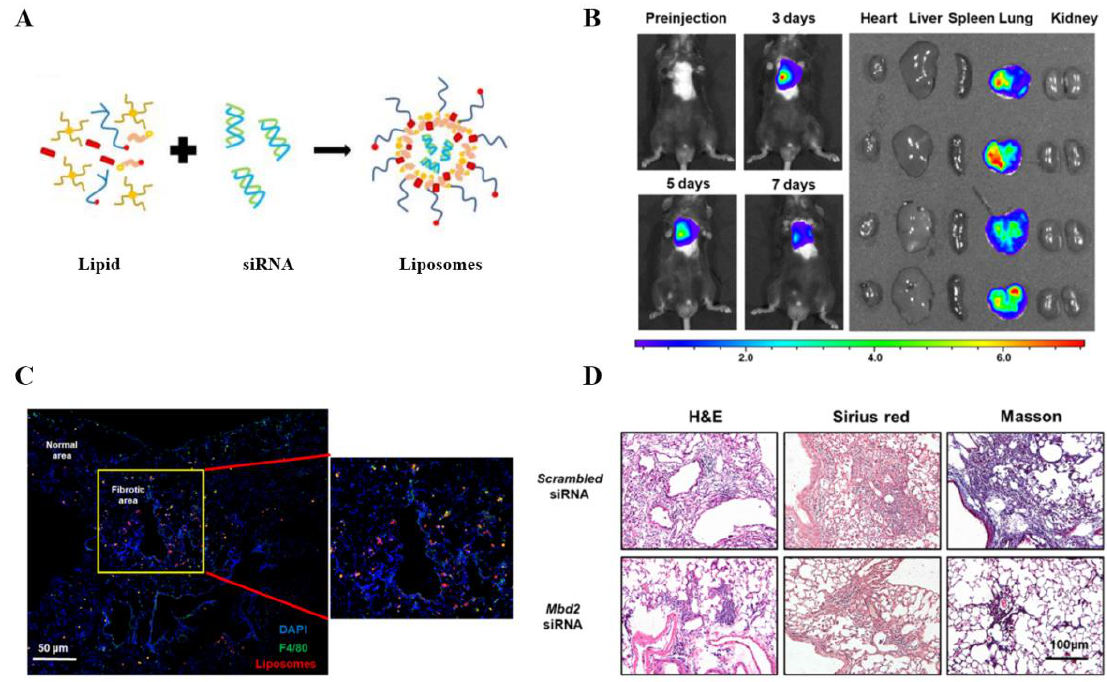
Figure 5. Mbd2 siRNA-loaded liposomes protected mice from BLM-induced pulmonary fibrosis [59]. ( A ) Schematic diagram of Mbd2 siRNA-loaded liposomes preparation. ( B ) Representative in vivo images of the mouseintratracheally administrated with DiR-labeled liposomes ( Left ) and ex vivo images of major organs from mice ( Right ). ( C ) Thebiodistribution of liposomes in lungs from BLM- induced mice. ( D ) Representative results for H&E, Sirius red, and Masson staining indicated in- tratracheal administration of Mbd2 siRNA – loaded liposomes provided protection for mice against BLM induced pulmonary fibrosis.